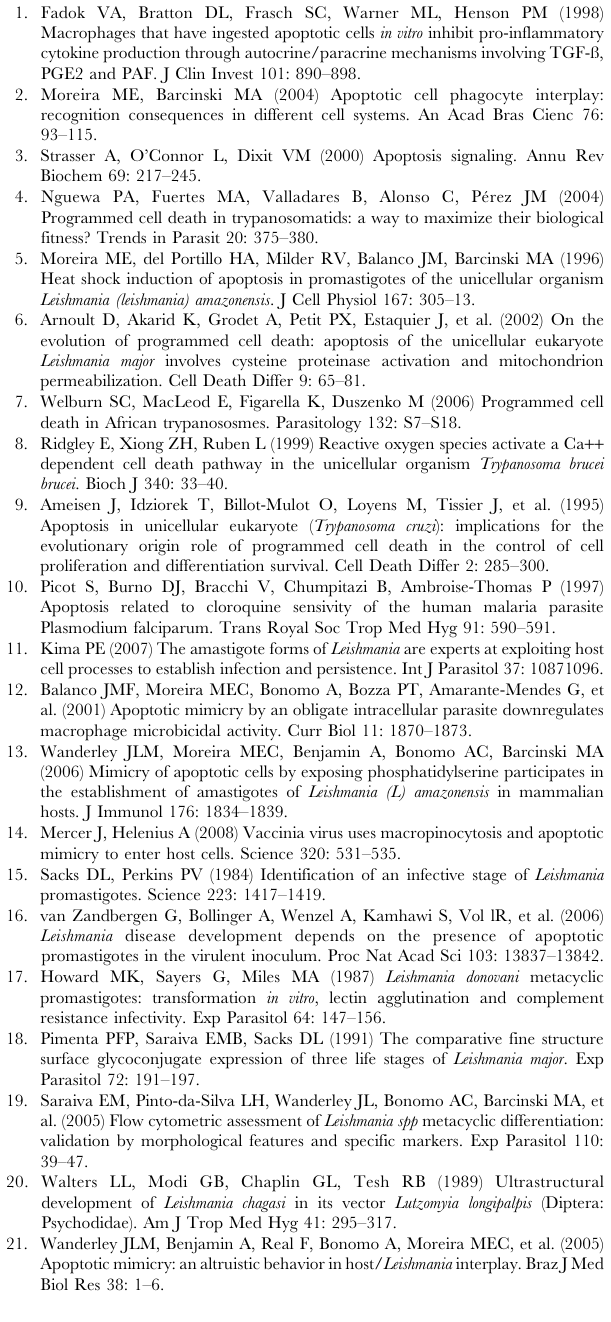
Figure S5 Found at: doi:10.1371/journal.pone.0005733.s005 (0.39 MB TIF) Figure S6 Found at: doi:10.1371/journal.pone.0005733.s006 (1.87 MB TIF) Movie S1 Found at: doi:10.1371/journal.pone.0005733.s007 (0.17